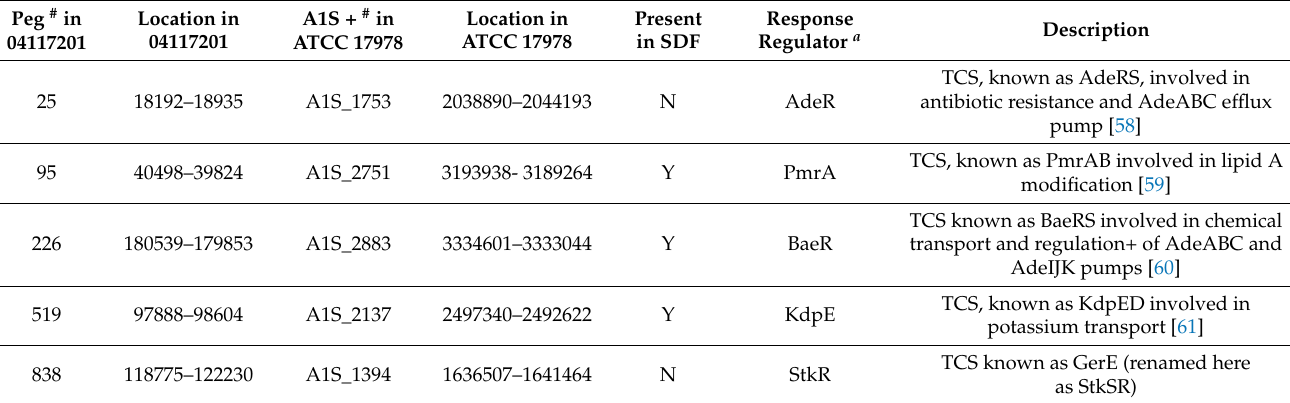
Table 2. Response regulators identified in the clinical Acinetobacter baumannii